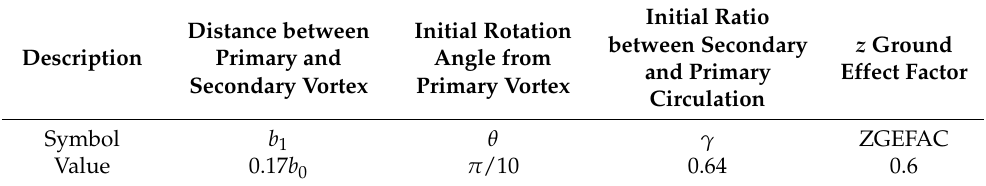
Figure 9. Comparison of starboard vortex trajectory, “theory” referring to point vortex dynamics method this paper, “ref1” and “refer2” are CFD results of papers [14,15], respectively. Table 2. Description, symbols, and values of the parameters in the IGE phase. The suggested values are based on the papers [32,33] and the comparison of theoretic results with those of [14,15].